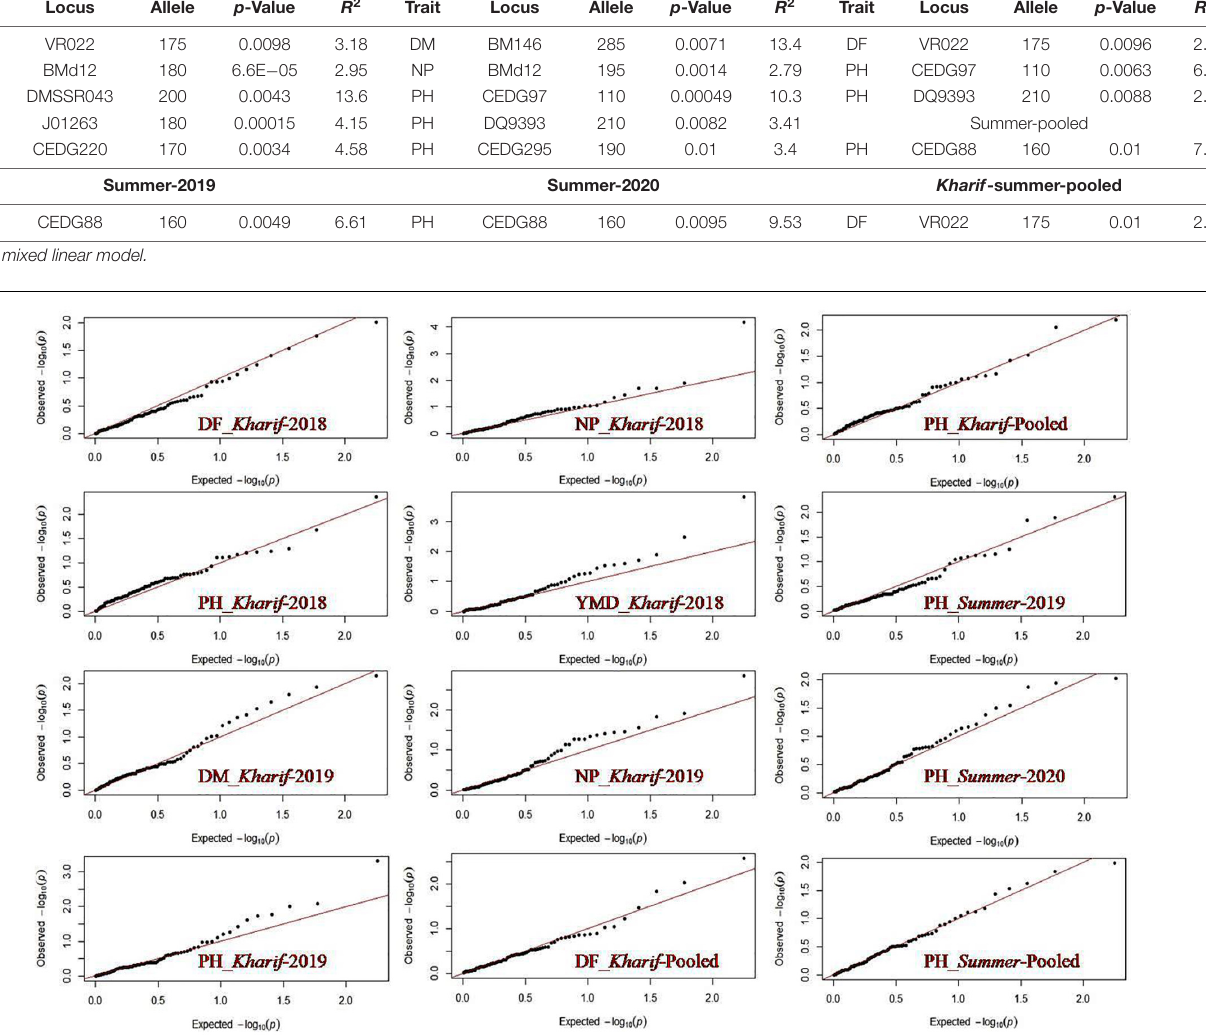
FIGURE 6 | QQ plot showing association of markers with yield-related traits in mung